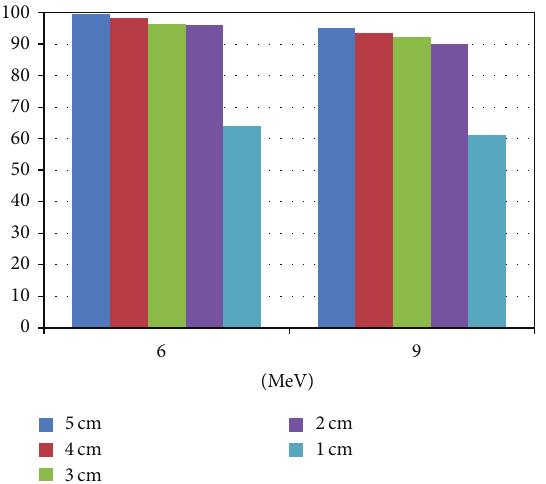
Figure 6: Gamma analysis results for beams with 6 and 9 MeV energy, for cut-out diameters of 4, 3, 2, and 1cm using a 5 cm circular cone at 100cm SSD ( 𝑦 -axis is